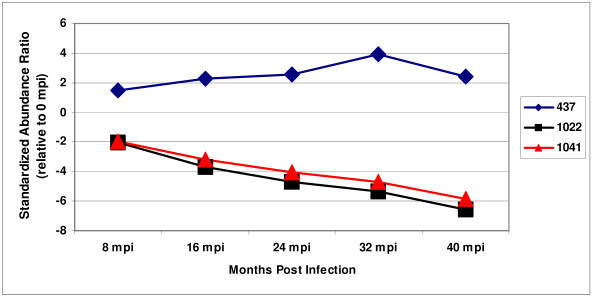
Proteins that exhibited a steady increase or decrease in abundance throughout disease progression. The average standardized abundance ratios of the top three ranked proteins used in the disease progression classier (437, 1041, 1022) are shown. The consistent increase or decrease in abundance over the course of the experiment illustrates the utility of the relative abundance of these spot features in classifying the urine samples with respect to date post infection.